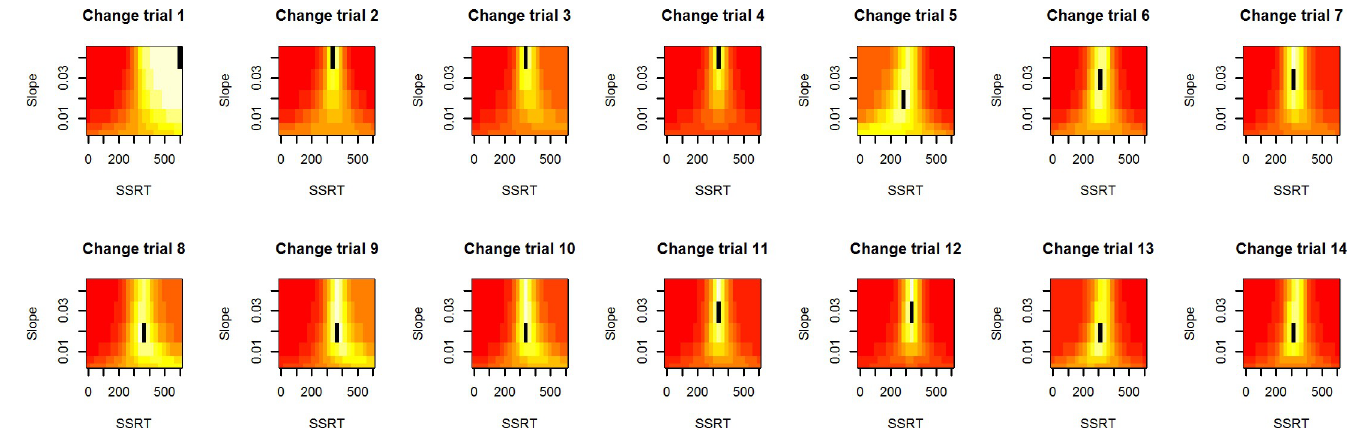
Fig 10. Likelihood estimates during Experiment 2. As Fig 2, the PSI adjusted method’s posterior distribution for the example participant. Colors indicate probability of the parameter combinations, the error rate dimension was averaged over. Despite considerable Go-response slowing, the parameters receiving the highest probability do not reach the upper boundaries of the parameter